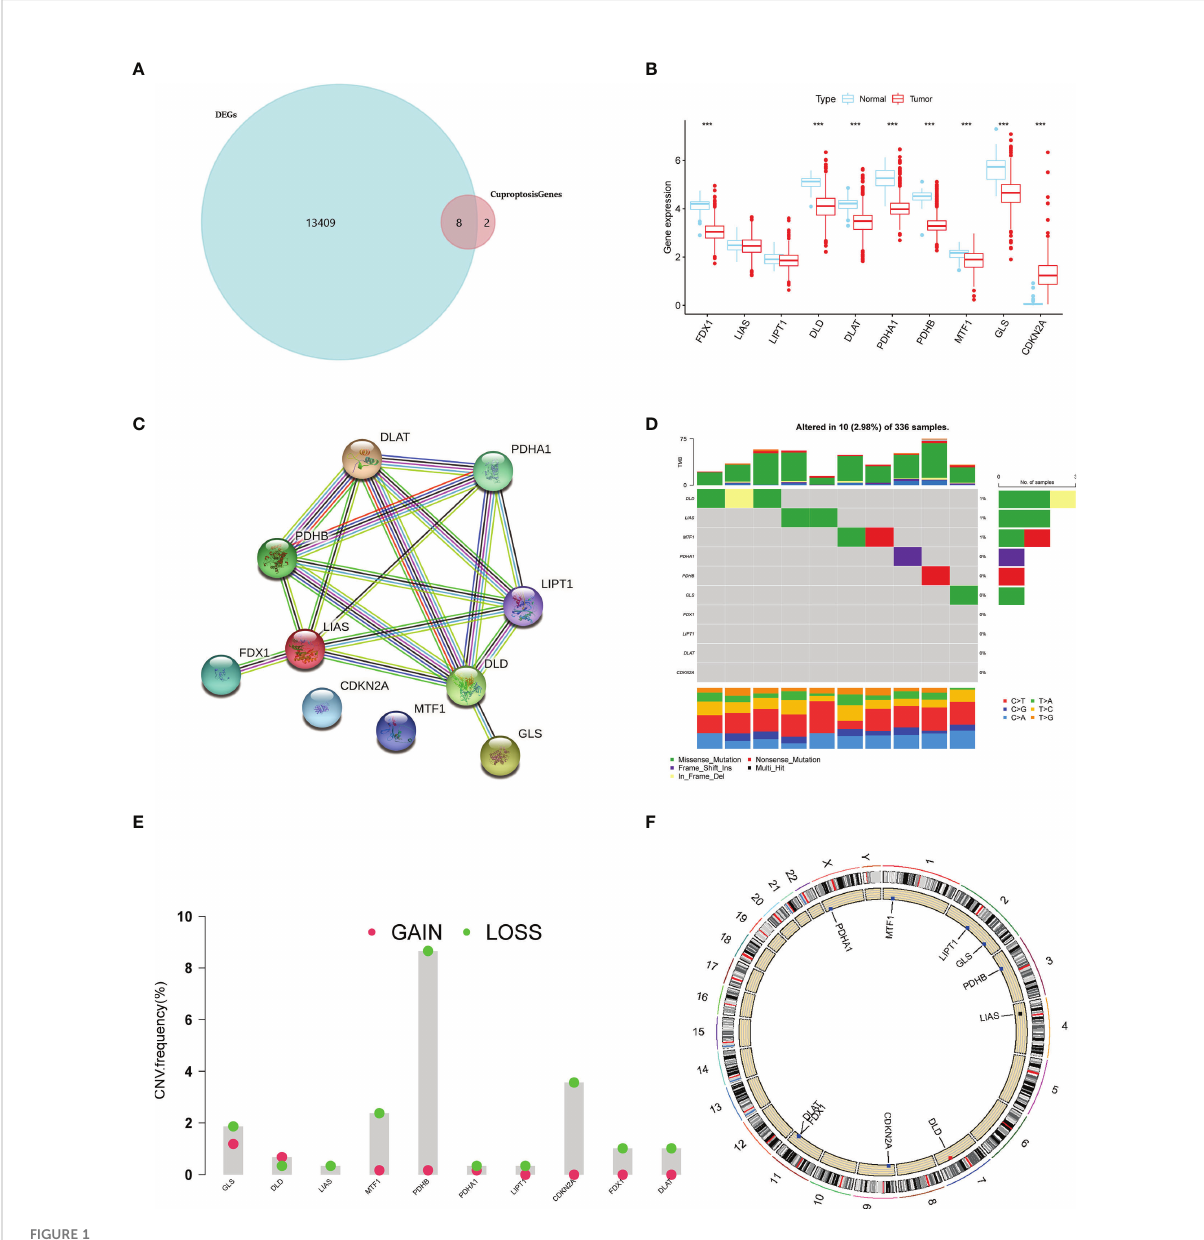
FIGURE 1 A landscape of key cuproptosis-associated genes (CAGs) in ccRCC. (A) Venn diagram of CAGs and ccRCC-derived DEGs. (B) Expression level of CAGs between tumors and normal tissues in ccRCC. (C) PPI network of CAGs. (D) Genetic mutation of CAGs in ccRCC samples. (E) CNA frequency of CAGs in ccRCC samples. (F) CNV sites of CAGs on chromosomes ( p < 0.001 ***). DEGs: differentially expressed